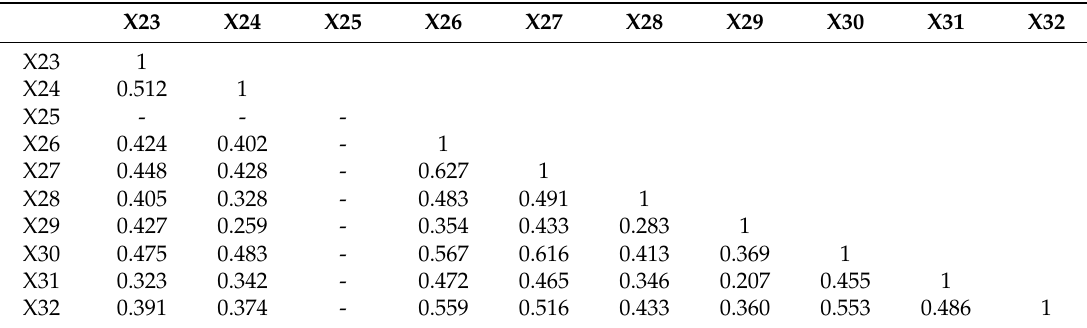
Table 4. The relevance test of the social e ff ect indicators of green technology